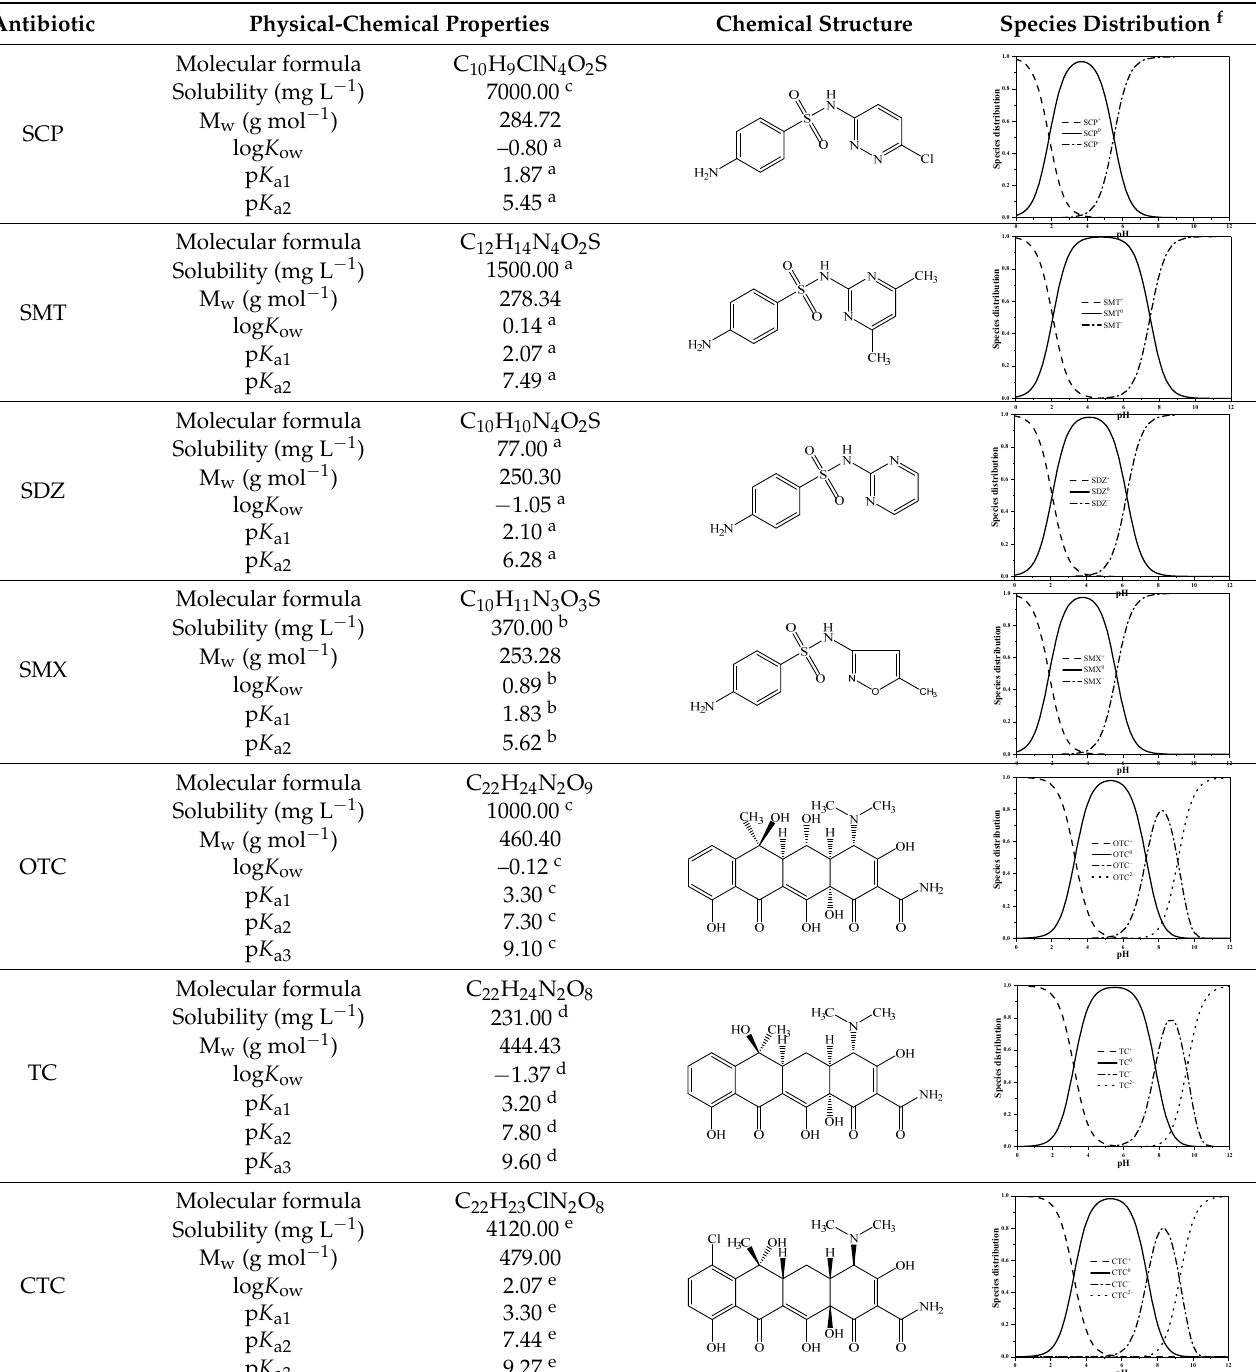
Table 1. Physicochemical properties of the target antibiotics.